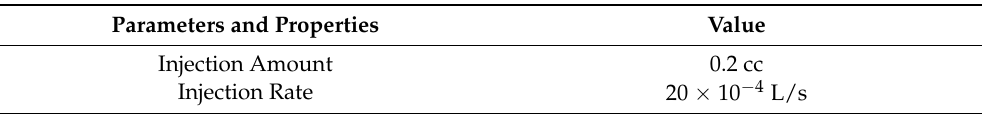
Table 2. Properties and parameters for the nanofluid convection and nanoparticle transport models (Data extracted from